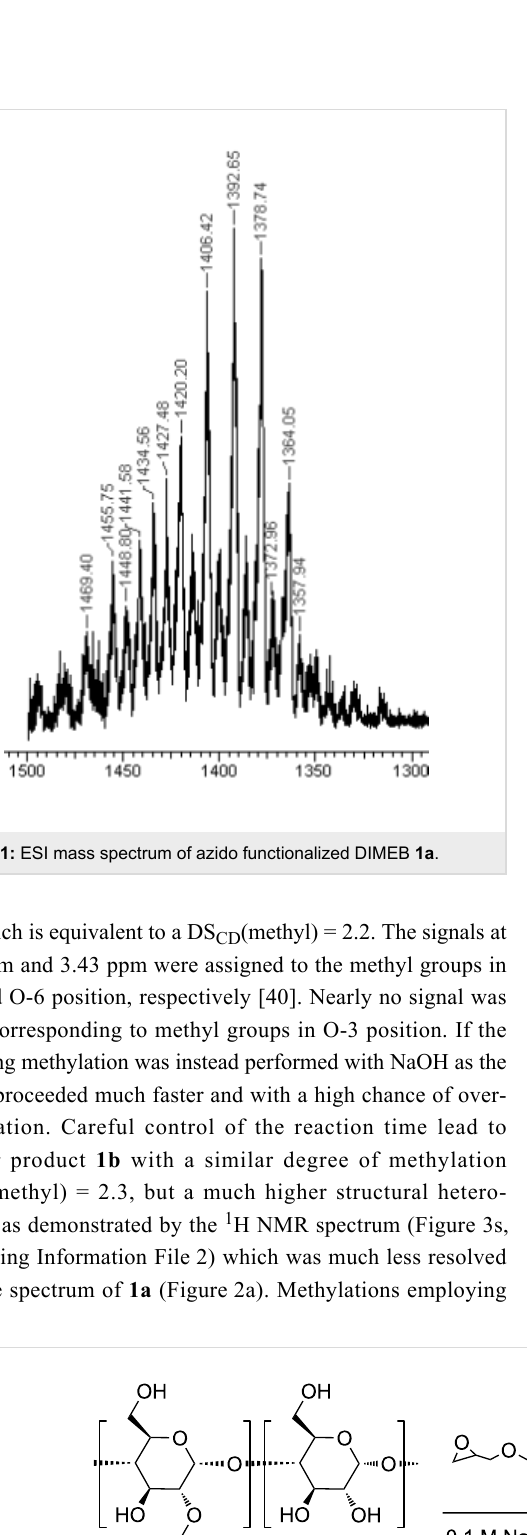
Scheme 2: Synthesis of propargylated HES 2 .